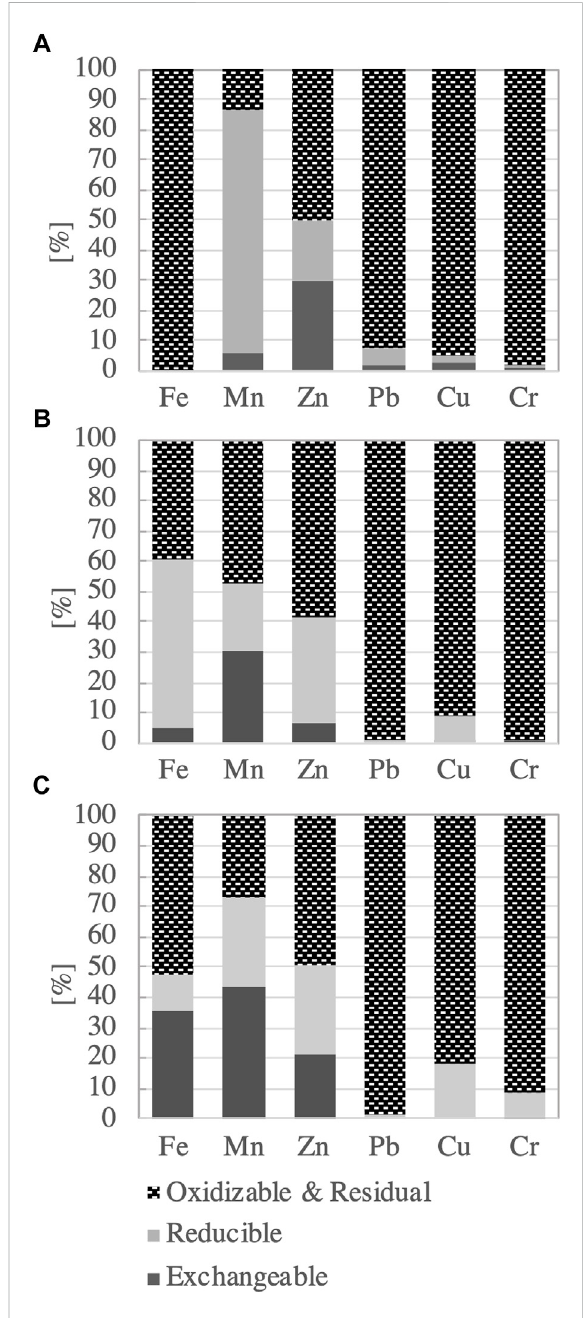
FIGURE 3 Trace metals fractionation in initial soil (A) , digestate (B) and digestate amended soil (C) from the soil column experiment (mean ± standard deviation, n =